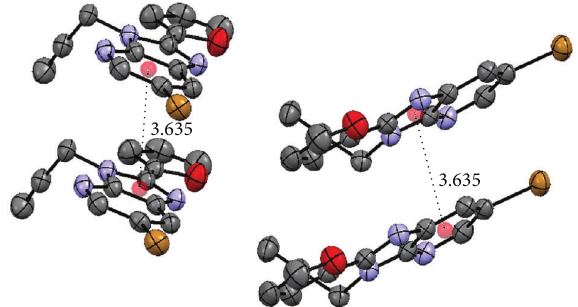
Figure 3: Intermolecular 𝜋 - 𝜋 interactions.